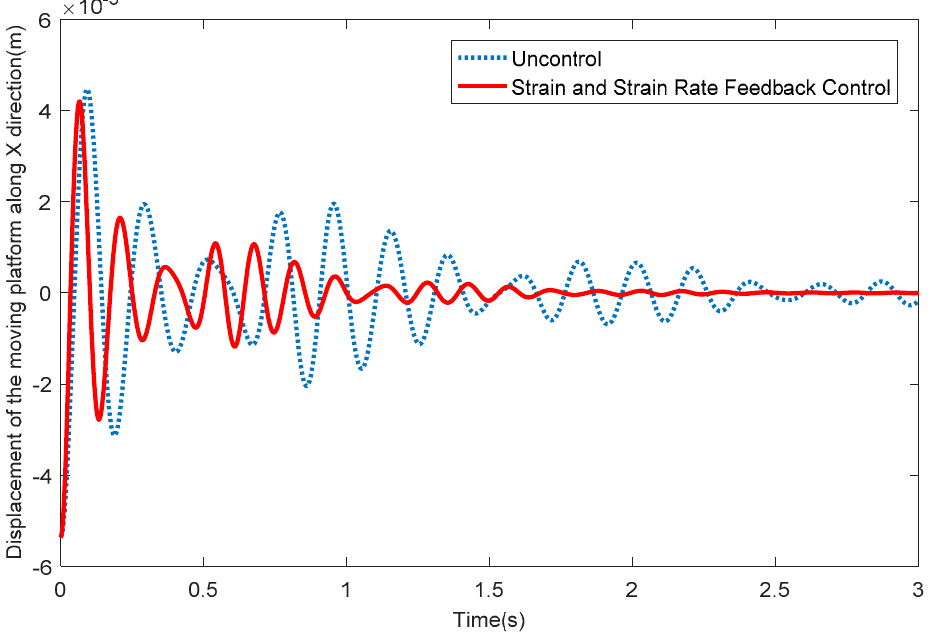
Figure 9. Elastic displacements of the moving platform along the X direction.